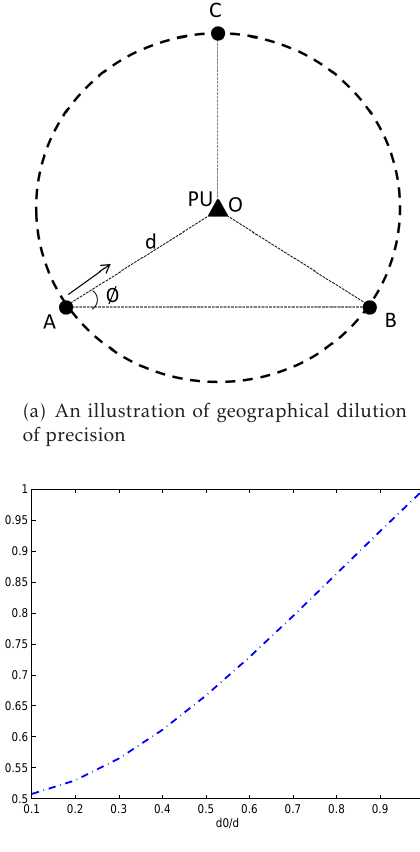
(b) CRLB will decrease as the distance between the CR node and PU decrease Figure 2. Geographical layout of the CR nodes affects the